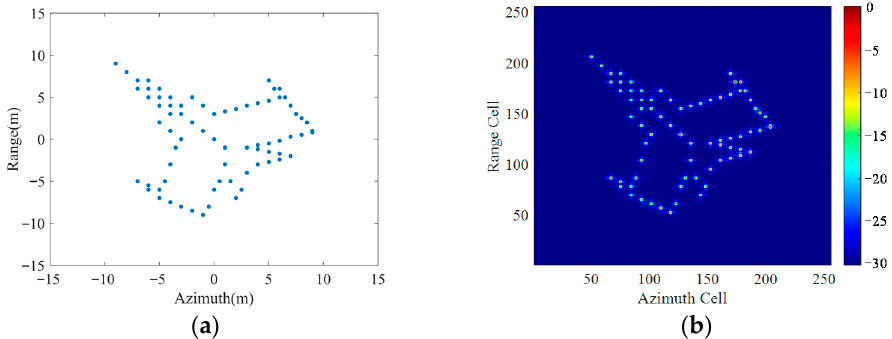
Figure 10. The simulated aircraft model: ( a ) The coordinate distribution of the scattering points; ( b ) The ideal ISAR image. Assuming that the motion compensation has been completed, the target equivalently rotates at a variable acceleration. We set different motion parameters and conducted three experiments with different noise levels and sampling ratios. The motion parameters and imaging conditions are presented in Table 1. Table 1. The motion parameters and imaging conditions of the three experiments. Parameters and Conditions Experiment 1 Experiment 2 Experiment 3 angular velocity(rad/s) 0.08 0.06 0.03 angular acceleration(rad/s 2 )